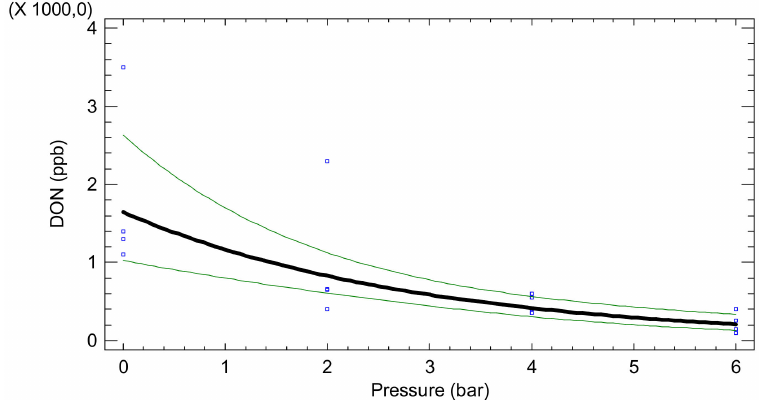
Figure 1. An exponential model to describe the relationship between DON and pressure in the year 2019. Outer lines represent confidence